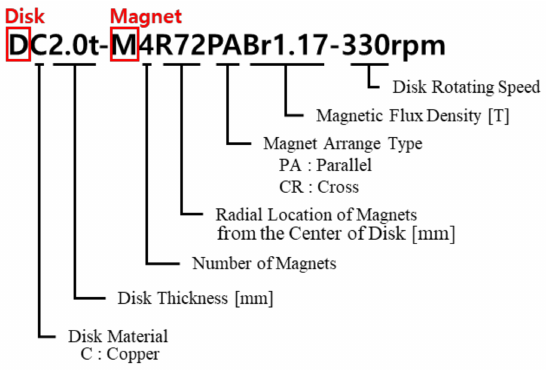
Figure 1. ECB label. For the initial simulations, cases were combined with each parameter: three disk thicknesses (2.0, 2.5, and 3.0 mm), four numbers of magnets (4, 6, 8, and 10), two magnet arrangements (parallel and cross arrangement), and three rotational speeds (330, 400, and 600 RPM). A magnetic flux density of 1.17 T and radial location of magnets of 77 mm were used. For the additional simulations, cases of added magnets (12, 16, and 20), higher magnetic flux densities (3.59 T and 8.42 T), and extended radial location of magnets (92, 122, and 155 mm) were